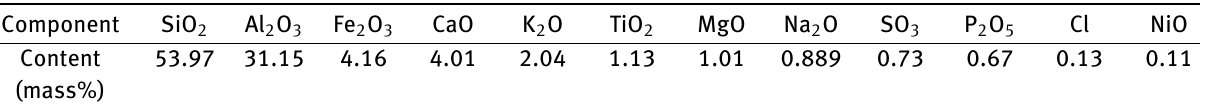
Table 2: Chemical composition and physical properties of cementitious materials Chemical